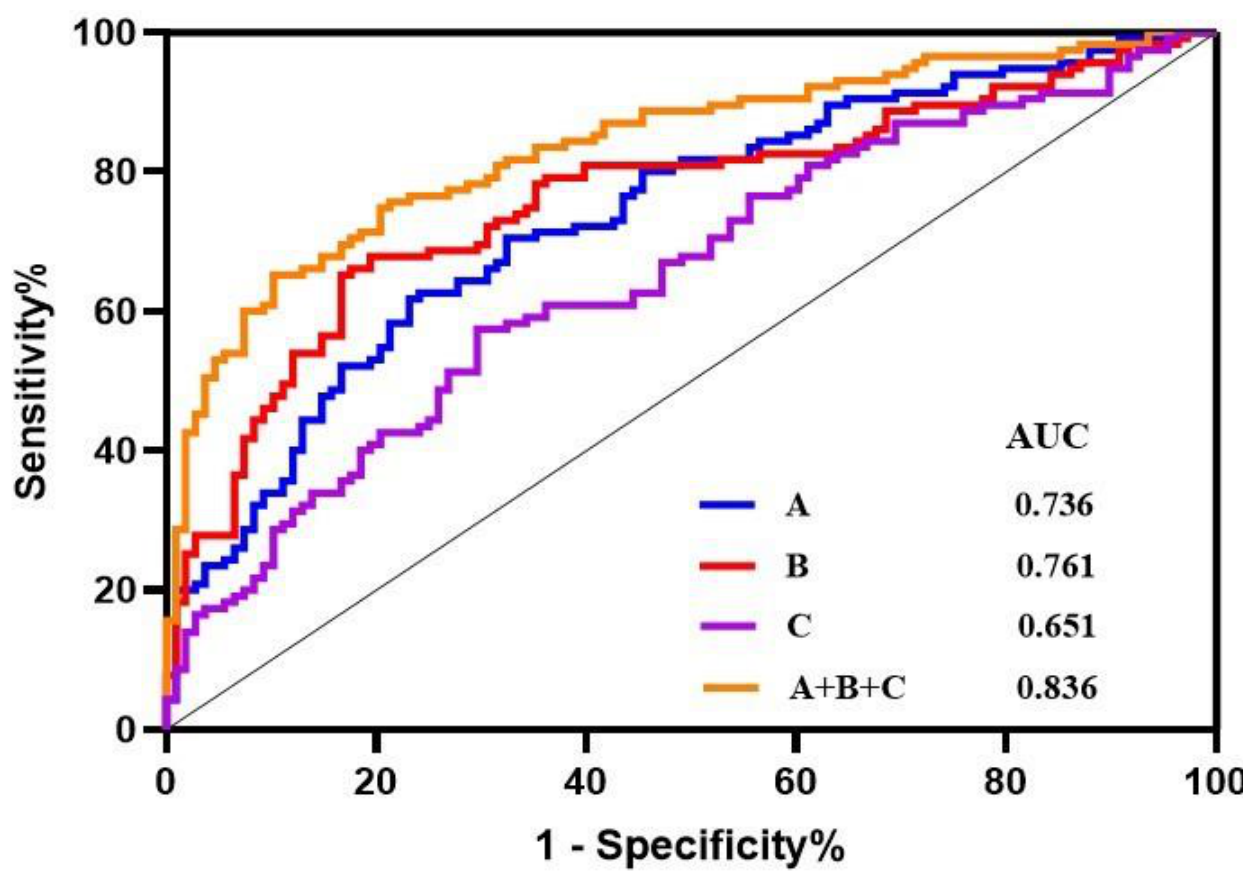
Figure Figure 5. Receiver operating characteristic curve analysis (ROC) of TAG (18:0/18:1/20:0), PC